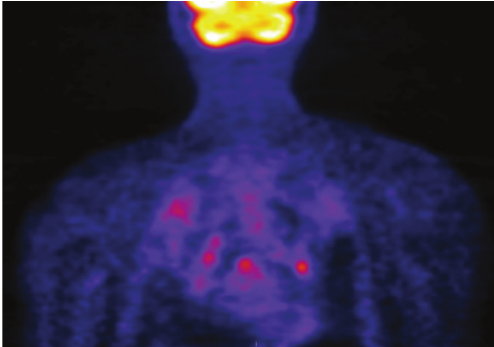
Figure 3: Coronal FDG-PET shows mild mediastinal and bilateral hilar FDG uptake, which is nonspecific but consistent with sarcoidosis.